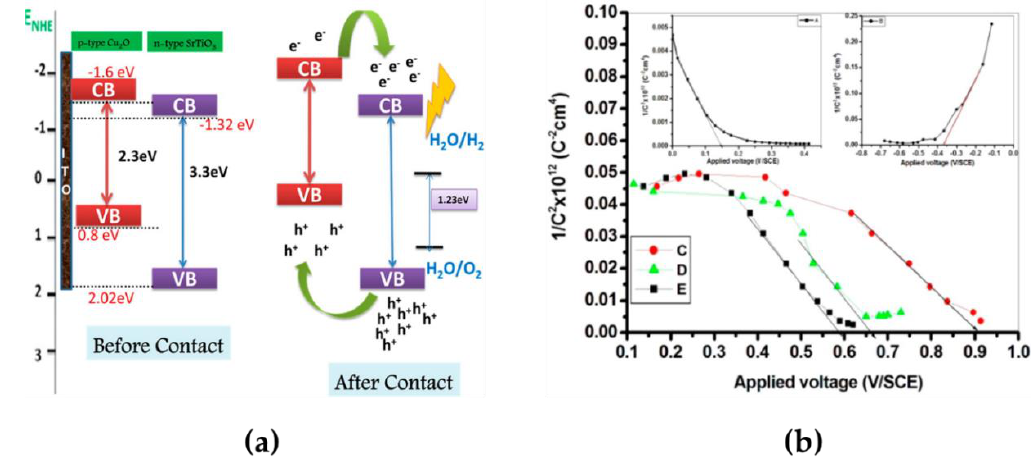
Figure 7. ( a ) Energy band diagram of Cu 2 O and SrTiO 3 before and after formation of the p–n junction, ( b ) Photocurrent density vs. applied potential curve for (A) pristine Cu 2 O and (C) 343 nm of Cu 2 O/SrTiO 3 heterojunction [88]. Copyright 2014, American Chemical Society.